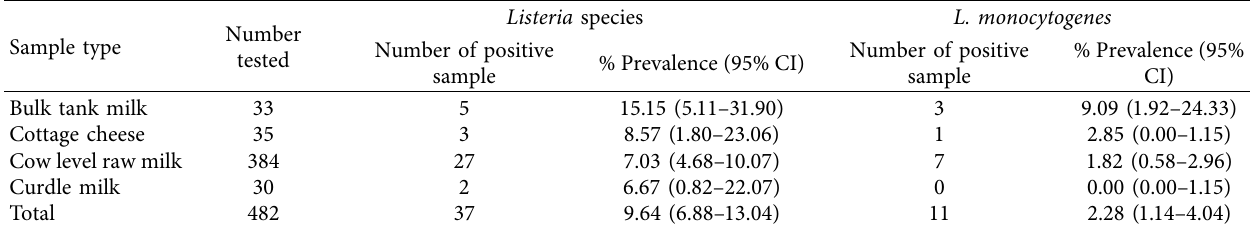
Table 2: Comparison of prevalence of Listeria species from different samples.